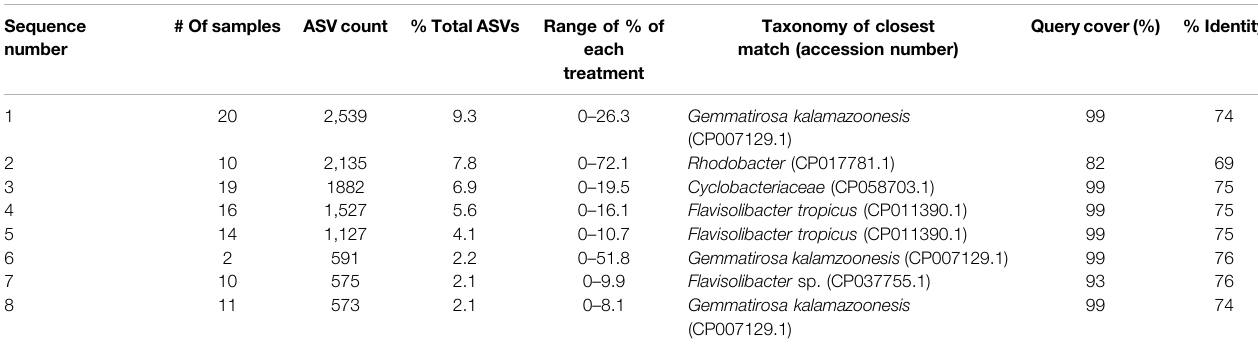
TABLE 5 | Abundance of dominant amplicon sequence variants (ASV) and closest taxonomic match. Sequence # Of samples ASVcount %Total ASVs Range of % of number